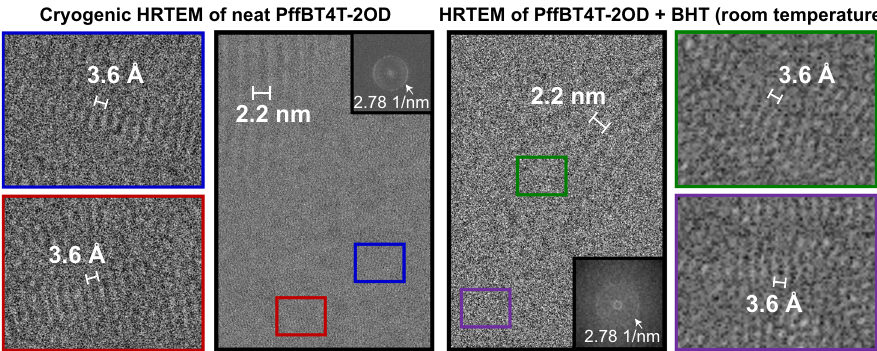
Fig. 4 Comparison of π stacking morphology of neat PffBT4T-2OD at cryogenic conditions (dose: 80 e/Å 2 ) vs. PffBT4T-2OD + BHT at room temperature (dose: 10 e/Å 2 ). Main panels show the 2.2 nm lamellar stacking and insets show π - π stacking. Red and blue insets are un fi ltered, while green and purple insets from room temperature imaging are Fourier- fi ltered. We observe the same morphology at room temperature with the addition of antioxidant as we do at cryogenic conditions, suggesting that antioxidants can be used for high-resolution room